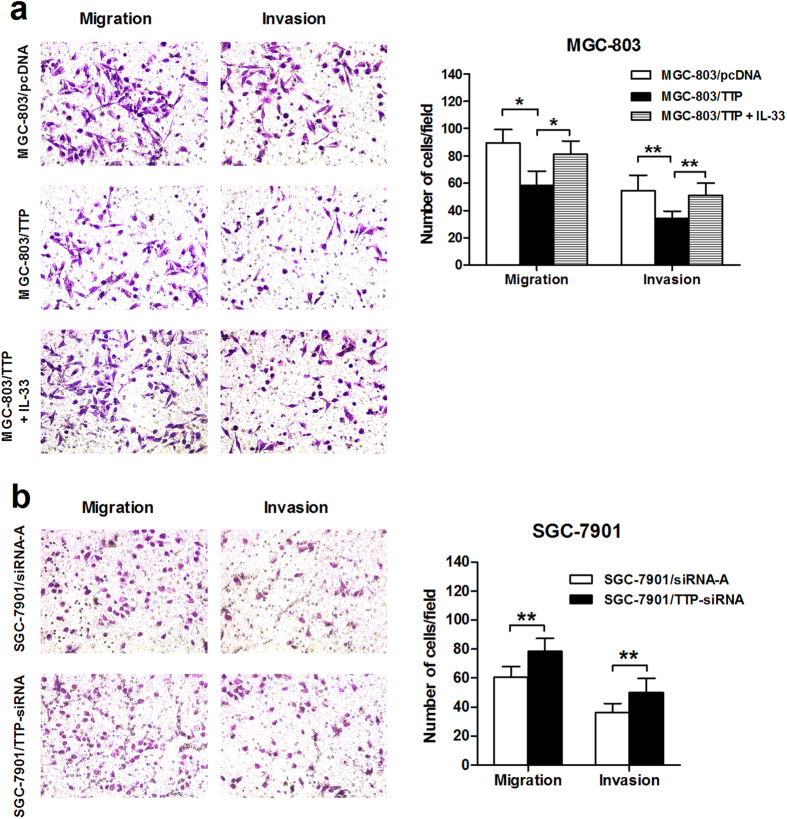
TTP inhibits the migration and invasion of gastric cancer cells in vitro through suppression of IL-33 expression.(a) Overexpression of TTP inhibited the migration and invasion of MGC-803 cells, while stimulation with recombinant human IL-33 (50 ng/ml) restored them. (b) Knockdown of TTP by siRNA enhanced the migratory and invasive abilities of SGC-7901 cells. Pictures shown are representative images of the migration and invasion assays (200× magnification). The data are represented as the mean ± SD of three independent experiments. *P < 0.05, **P < 0.01.